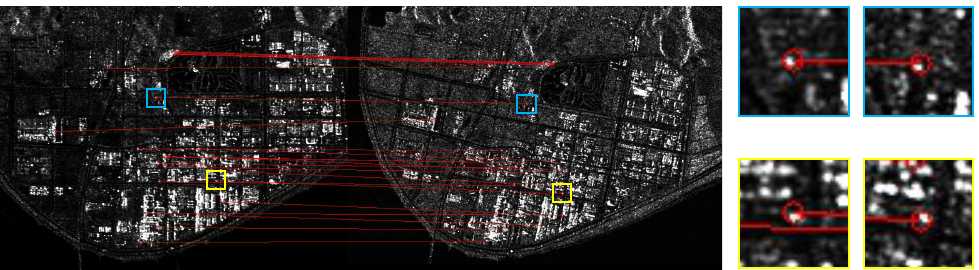
Figure 1. Illustration of small displacement errors in the matched point pairs obtained by Sim- CSPNet [20].